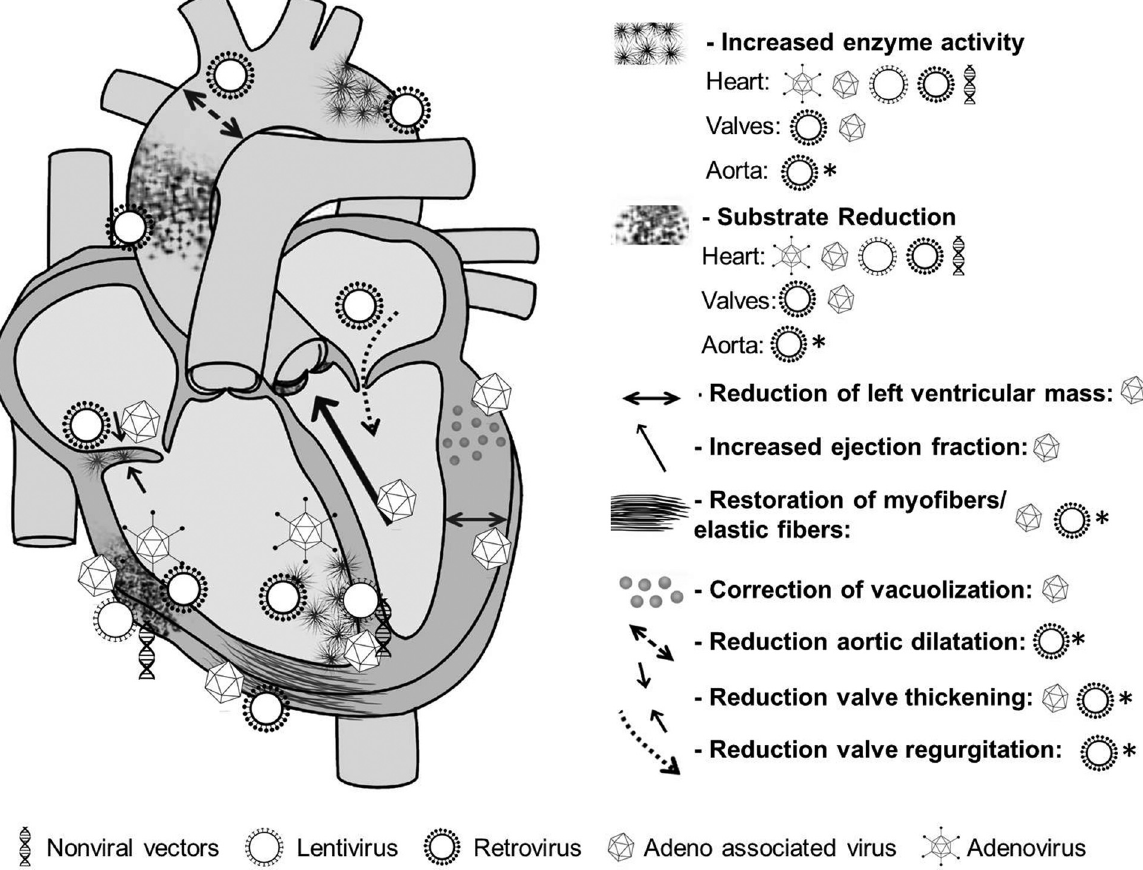
Figure 1 - Cardiovascular response to gene therapy depending on vector used, according to studies for lysosomal storage diseases. Schematic representa- tion of the heart and the aorta showing the most prominent cardiovascular manifestations of lysosomal storage diseases (right) with the results obtained from in vivo gene therapy using different vectors (bottom). Retroviral and adeno-associated viral vectors resulted in better outcome for many aspects of the disease (although most studies using other vectors did not analyse thoroughly the effect of gene therapy on cardiovascular manifestations and there is no data available). Valves and aorta are most difficult to treat, as most vectors do not reach these structures as easily as the myocardium. Some features were only restored or prevented when treated in the first days of life (represented by * next to the vector